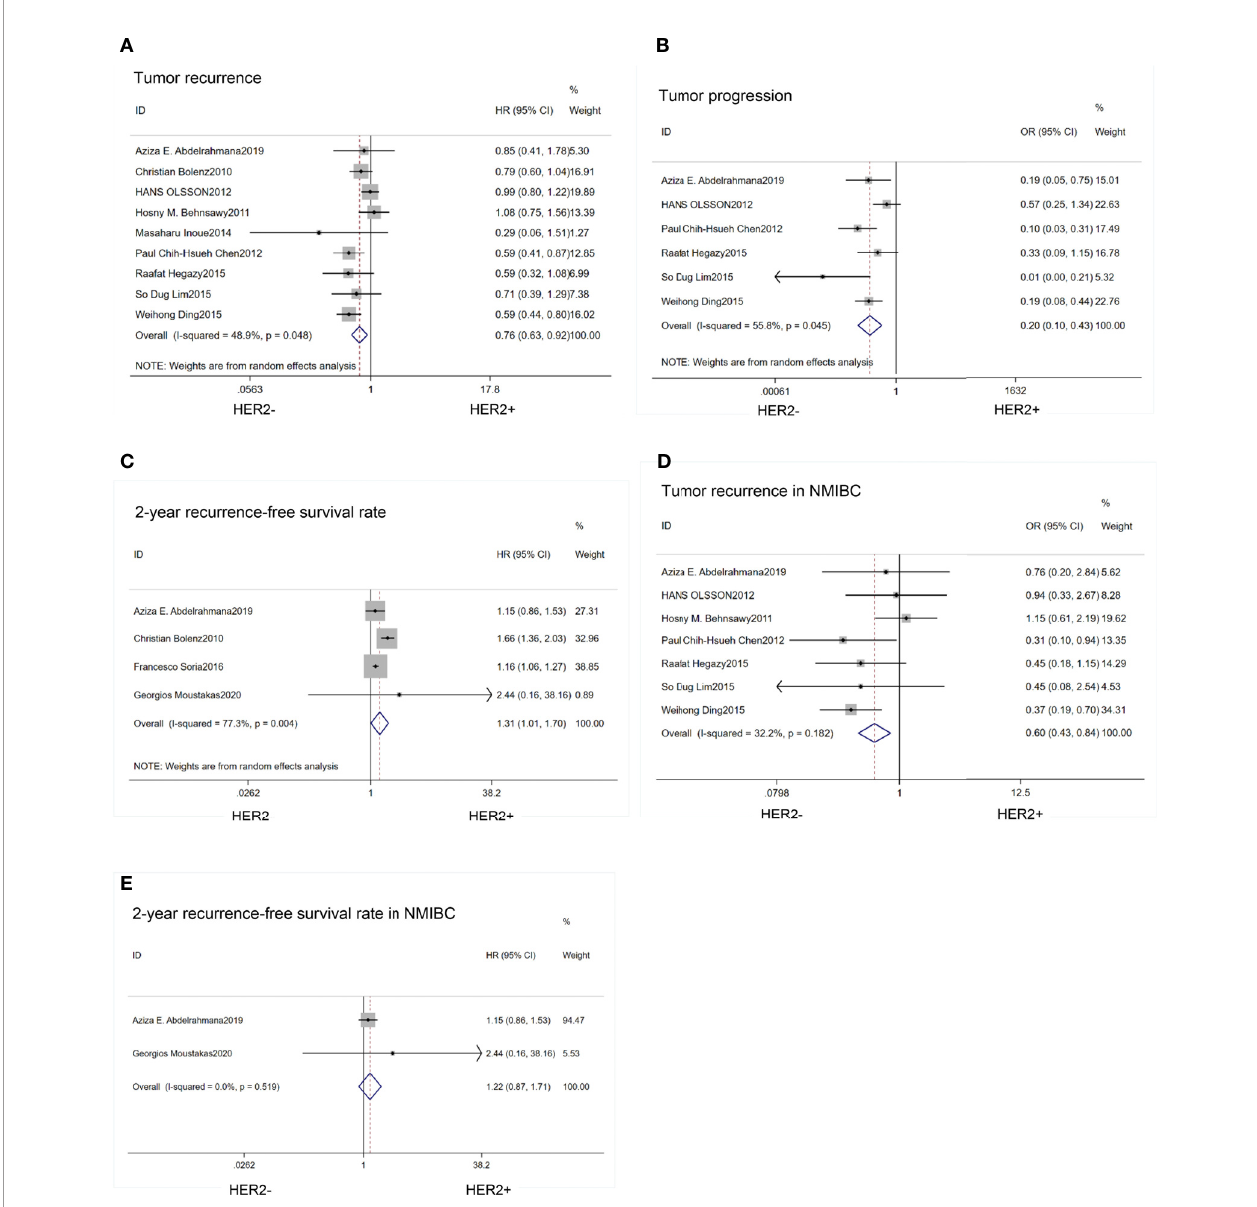
FIGURE 4 | Forest plots describing the correction of HER2 protein expression with recurrence (A) , progression (B) , 2-year RFS (C) , recurrence in NMIBC (D) , 2-year RFS in NMIBC (E) . RFS, recurrence-free survival; NMIBC, non-muscle invasive bladder cancer. OR, odds ratio; HR, hazard ratio; CI, con fi dence